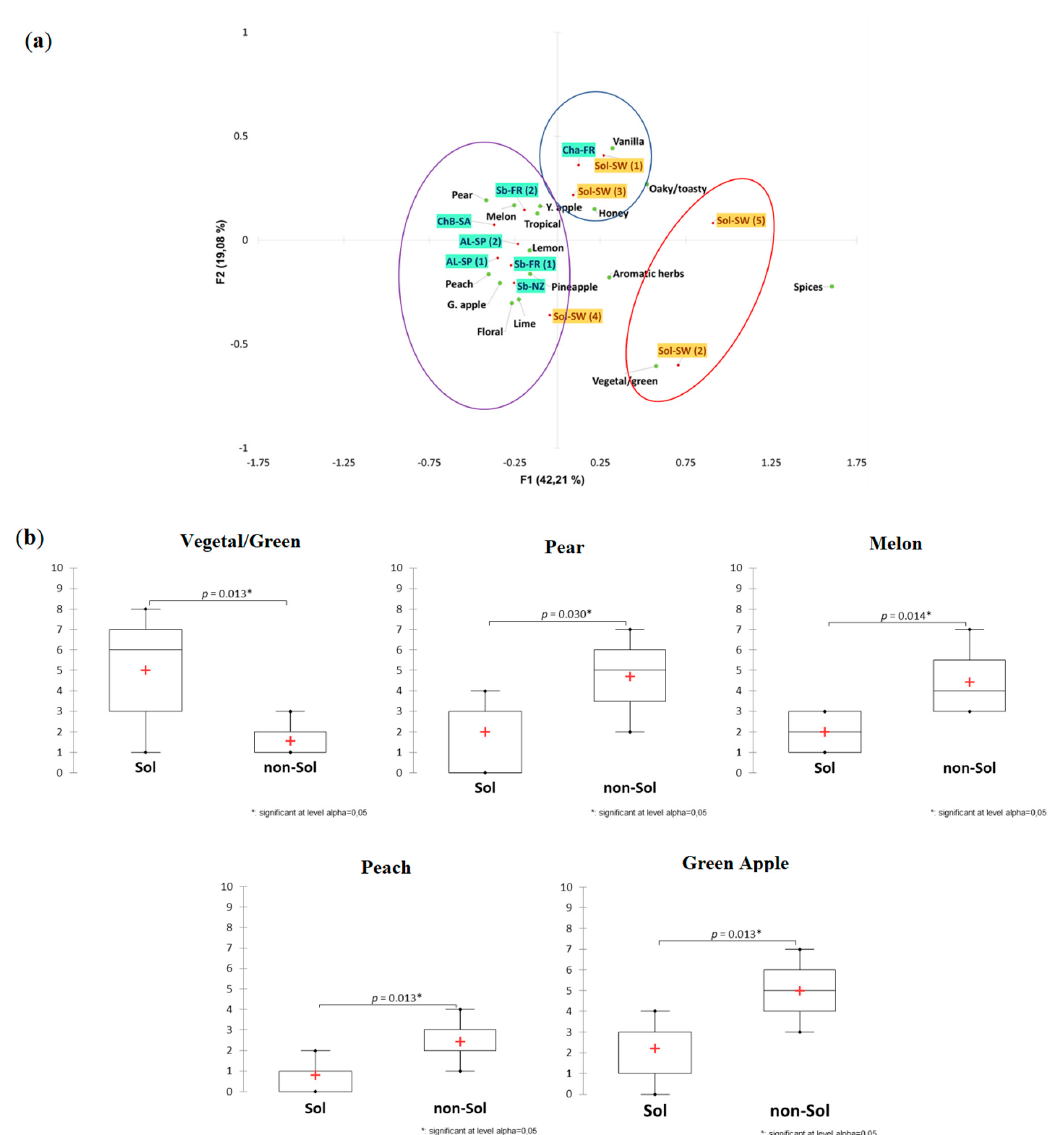
Figure 2. ( a ) Correspondence Analysis (CA) biplot representing the distribution of the wines according to the frequency of citation of the provided aroma descriptors. Ellipses represent the clusters found with the corresponding Hierarchical Cluster Analysis (HCA) analysis. ( b ) Box and whiskers plots illustrating the aroma attributes significantly different between Sol and non-Solaris wines based on a Student t -test.